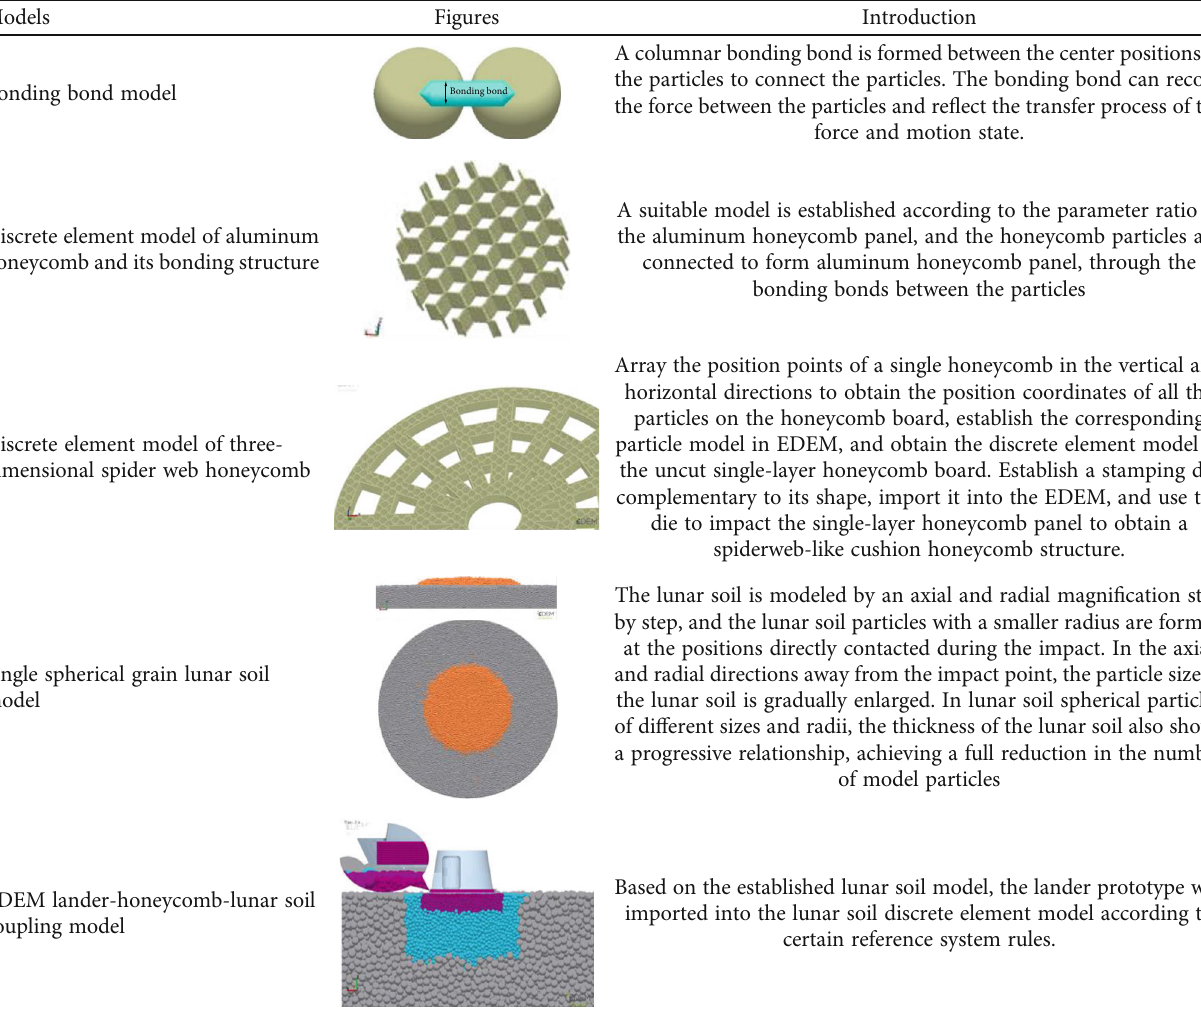
Figure 10: Schematic diagram of EDEM lander-honeycomb-lunar soil coupling Table 1: Discrete element parameters of cobweb honeycomb.